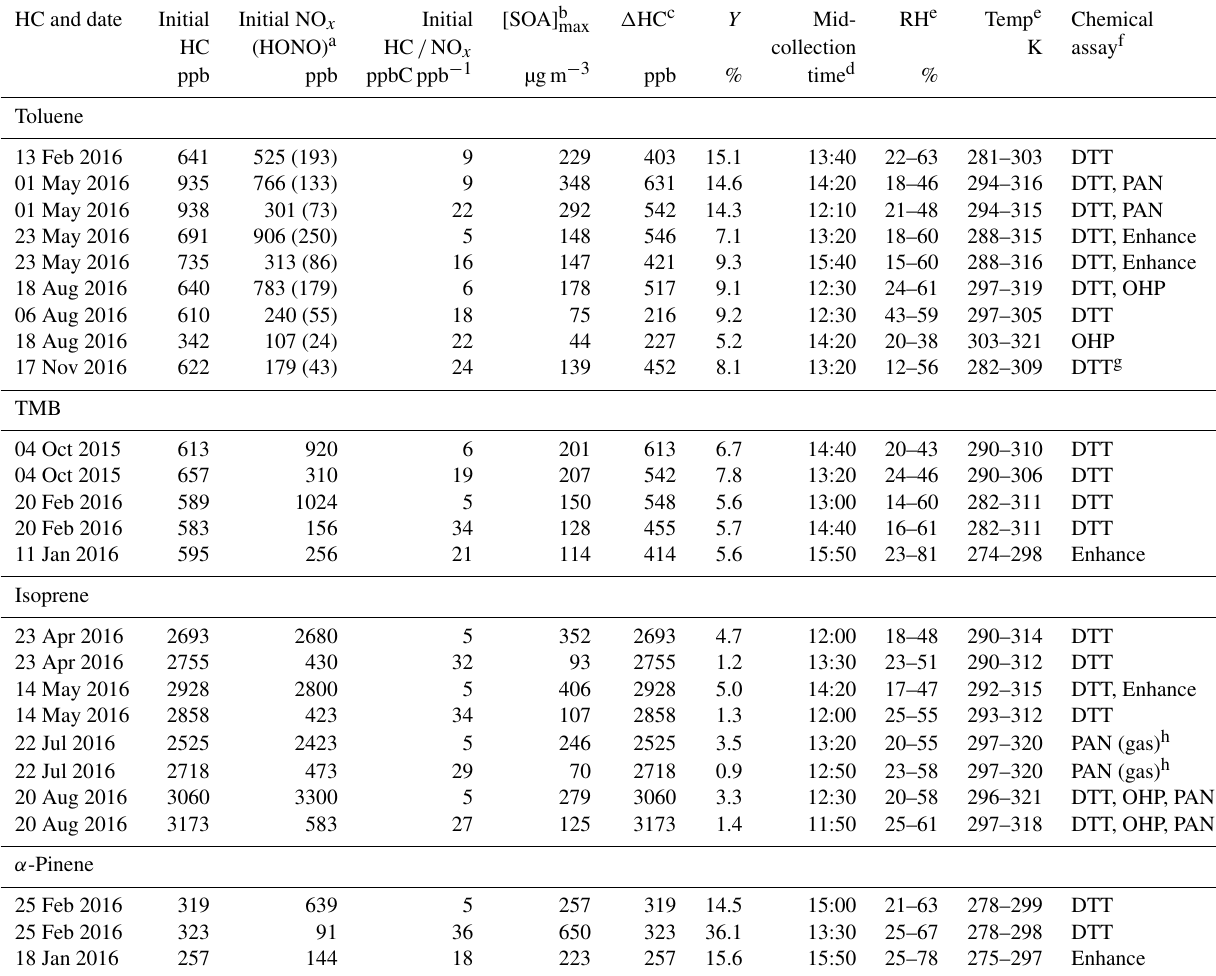
Table 1. Outdoor chamber experiment